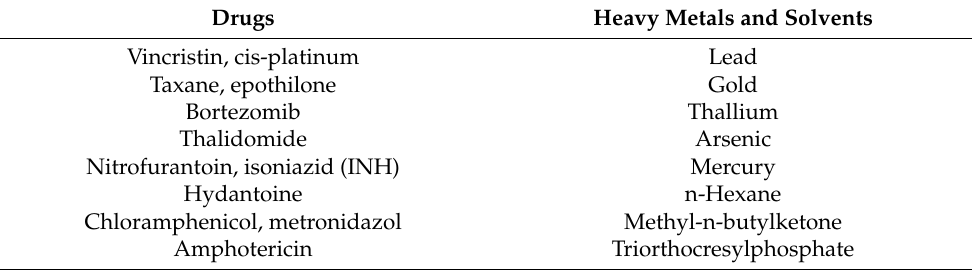
Table 5. Toxic agents associated with polyneuropathy